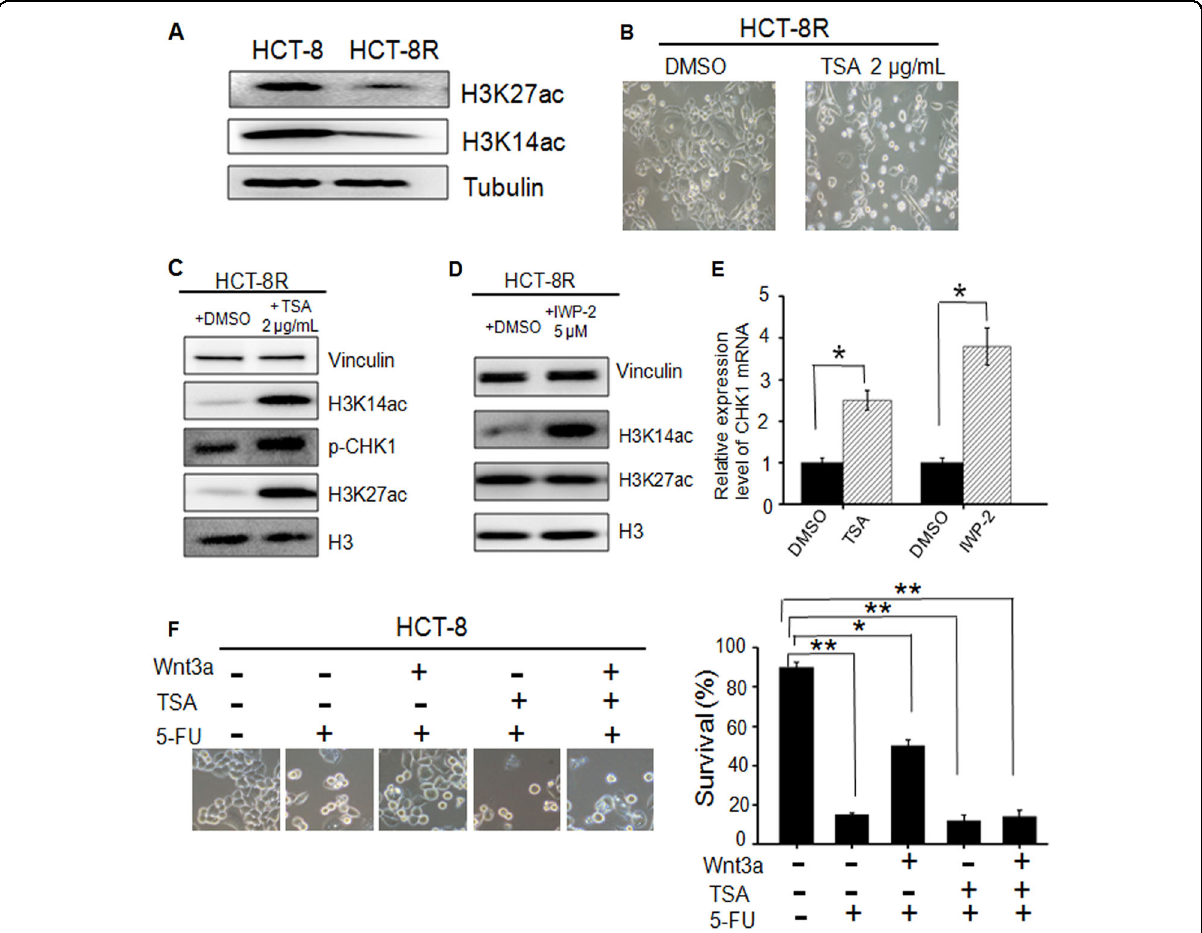
Fig. 6 Histone modi fi cation is involved in Wnt-mediated regulation of CHK1. a Histone acetylation status was different in HCT-8 and HCT-8R cells. Shown are the western blotting assays of H3K27ac and H3K14ac expression level. b TSA, a well-established histone deacetylase (HDAC) inhibitor, sensitized HCT-8R cells to 5-FU treatment. c Western blotting assay of HCT-8R cells treated with TSA. d Western blotting assay of HCT-8R cells treated with the Wnt signal inhibitor IWP-2. e CHK1 mRNA level in HCT-8R cells treated with IWP-2 or TSA. * p < 0.05. f Cell survival of HCT-8 cells treated with Wnt3a or TSA. ** p <